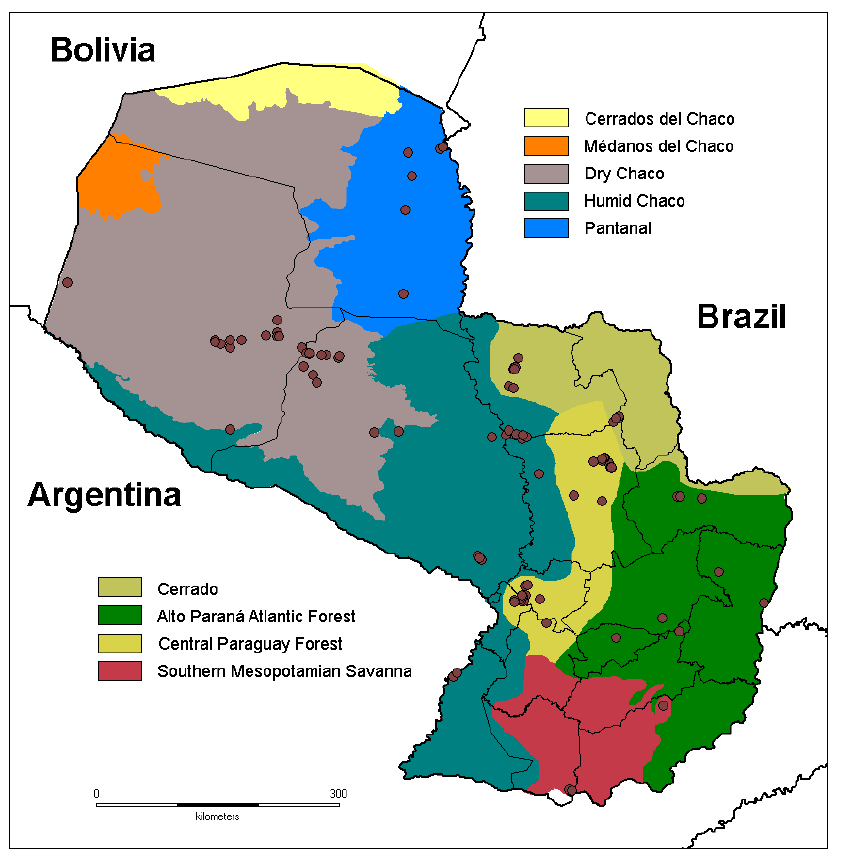
Figure 2. Ecoregions of Paraguay, showing the collecting sites (brown dots) for this project.